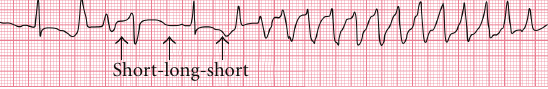
Short-long-short Figure 4: Short-long-short sequence preceding TdP.